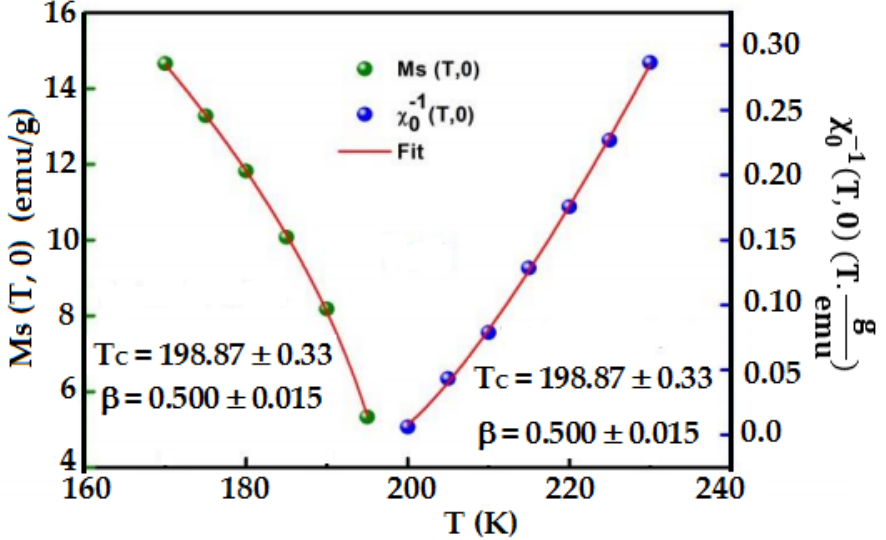
Figure 9. Temperature dependence of spontaneous magnetization 𝑀 𝑆 (𝑇,0) and the inverse of initial susceptibility 𝜒 0−1 (𝑇, 0) .